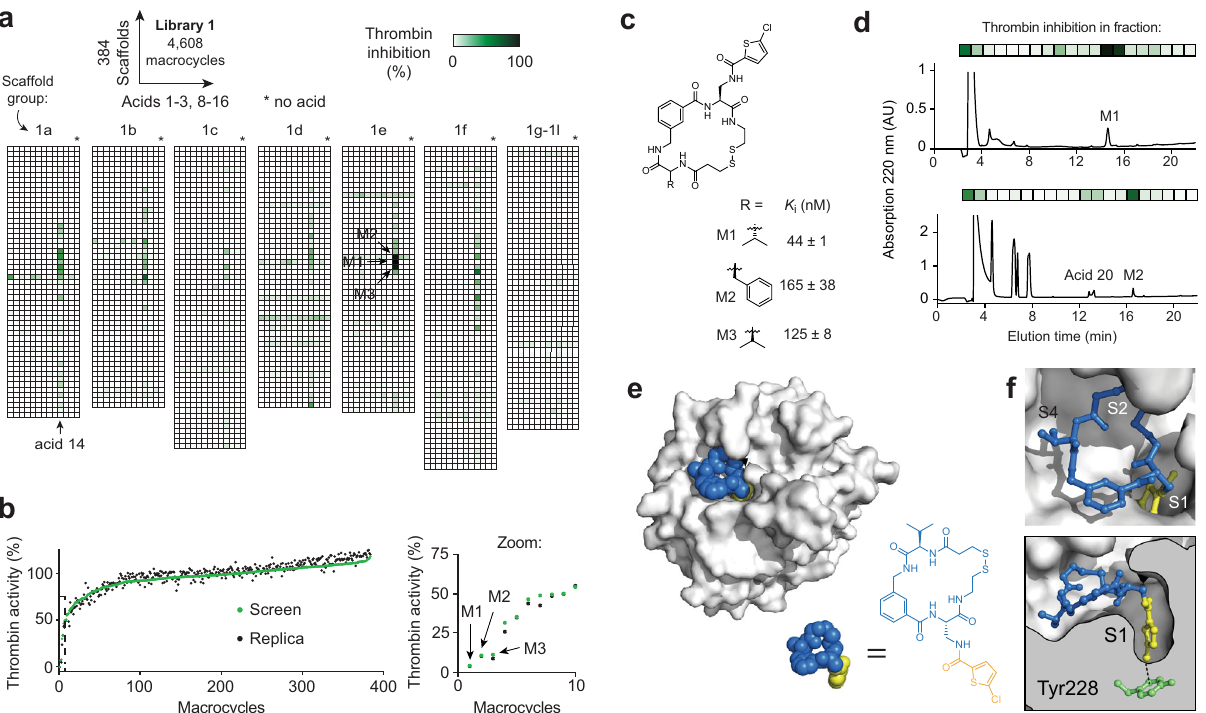
Fig. 3 Screening of macrocyclic compound library against thrombin, hit identi fi cation, and structural analysis. a Heat map with thrombin inhibition indicated for each macrocycle. The amino acid sequences of the scaffolds are provided in the Source Data fi le. b Replicate reaction (black) compared to original screen (green) of all macrocycles containing acid 14 . For each of the two independent experiments, the reactions were performed once and the thrombin inhibition was measured once. c Chemical structures and activities of the top three hits M1, M2, and M3. The mean values and SDs of three independent measurements are shown. d Chromatographic separation of the acylation reactions to generate M1 and M2 and analysis of the fractions for thrombin inhibition. e X-ray structure of M1 bound to human thrombin at 2.27 Å resolution (PDB 6Z48) (https://www.rcsb.org/structure/6Z48). The inhibitor is shown in the space- fi lling model with the scaffold in blue and the carboxylic acid in yellow. f Zoomed in structure of thrombin with the sub-sites indicated. The chlorothiophene group fi lls the S1 sub-site and forms an interaction with